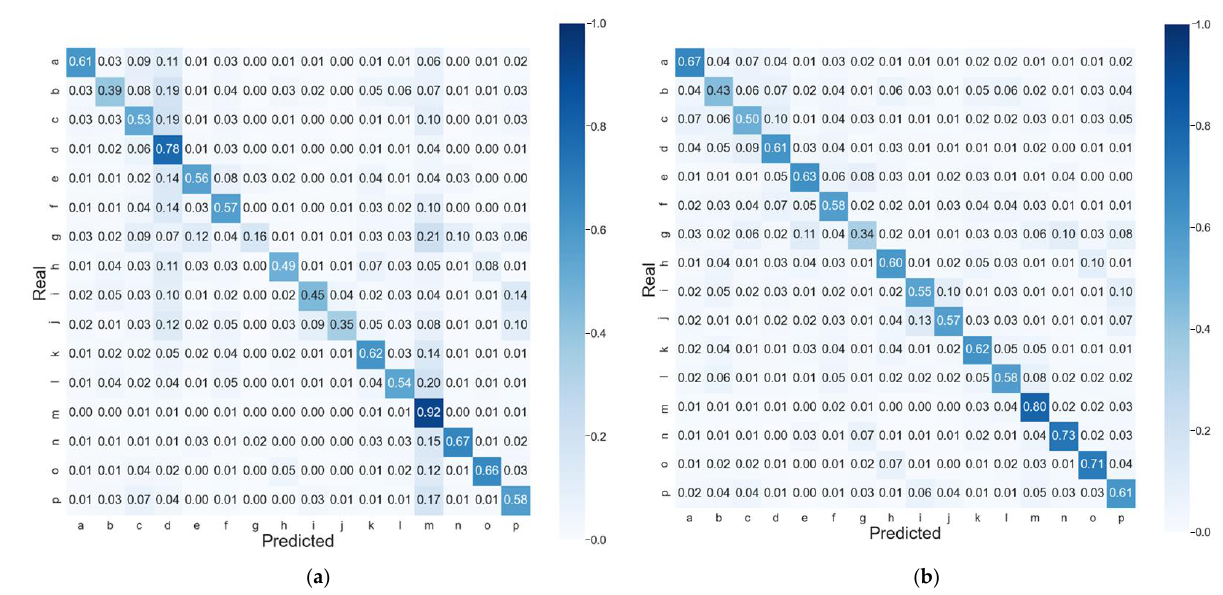
Figure 2. Normalized confusion matrices of PYTHIA predictions on the test dataset of best CV for the ( a ) global accuracy model and ( b ) balanced accuracy model.